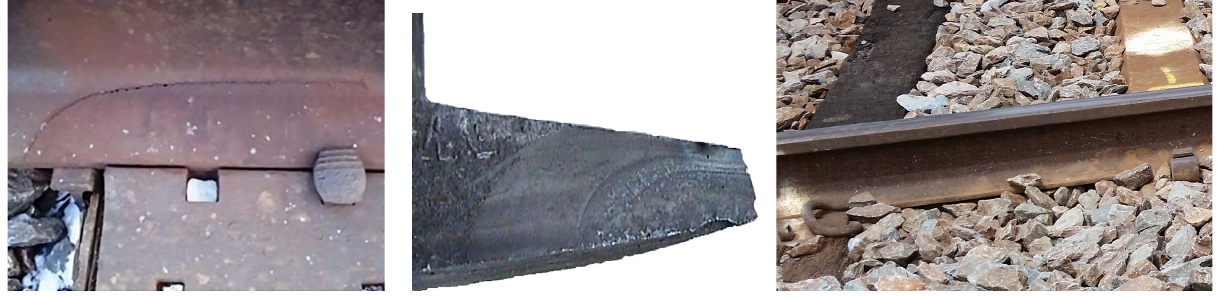
Figure 1. Longitudinal foot flaw (half-moon defect)